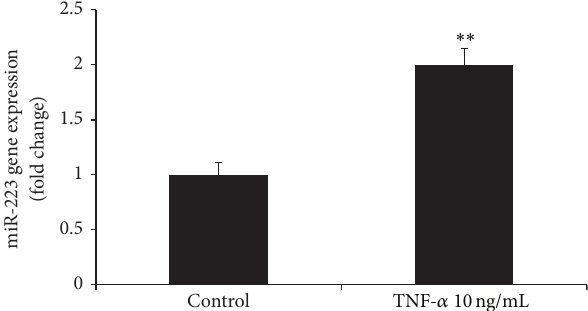
Figure 3: TNF- 𝛼 induces expression of miR-223 in human differ- entiated adipocytes. Human differentiated adipocytes were treated with TNF- 𝛼 (10ng/mL) for 24 hours. Expression of miR-223 was detected by real-time PCR. ∗∗ 𝑃 < 0.01 comparing to control; the comparisons of significance were carried out by unpaired Student’s 𝑡